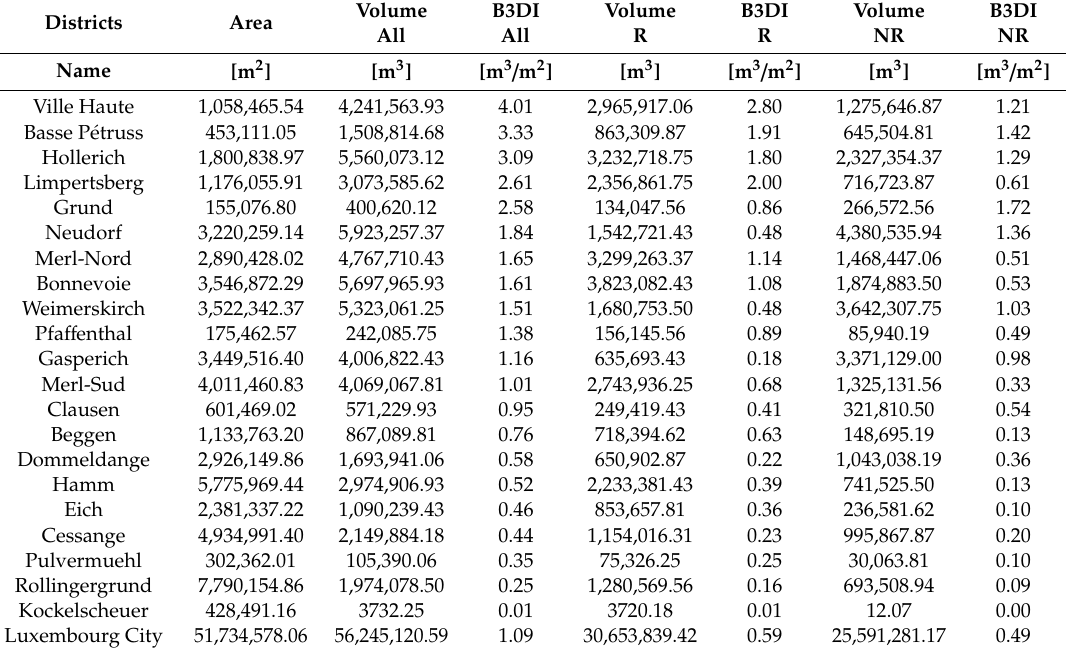
Table A1. Volume of buildings and Building 3D Density Index (B3DI) for residential (R) and non-residential (NR) buildings in Luxembourg City in 2019.